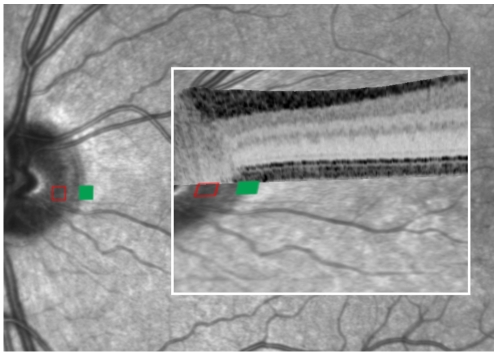
Ability of co-registration using the MultiModalMapper software to exactly map functional testing on anatomical recordings in a normal subject.The optic nerve head is the anatomical correlate for the physiological blind spot in the visual field. The hollow red square represents the brightest stimulus using microperimetry and was not detected by the subject (absolute scotoma) when projected onto the optic nerve head. In contrast, a much dimmer testing point (green square, 18dB decreased light intensity compared to the brightest stimulus) projected just outside the optic nerve area head was detected by the subject and shows normal light sensitivity. An overlay with the SD-OCT scan (inset, framed in white) shows the normal retinal layers within the area bordering the optic nerve head.